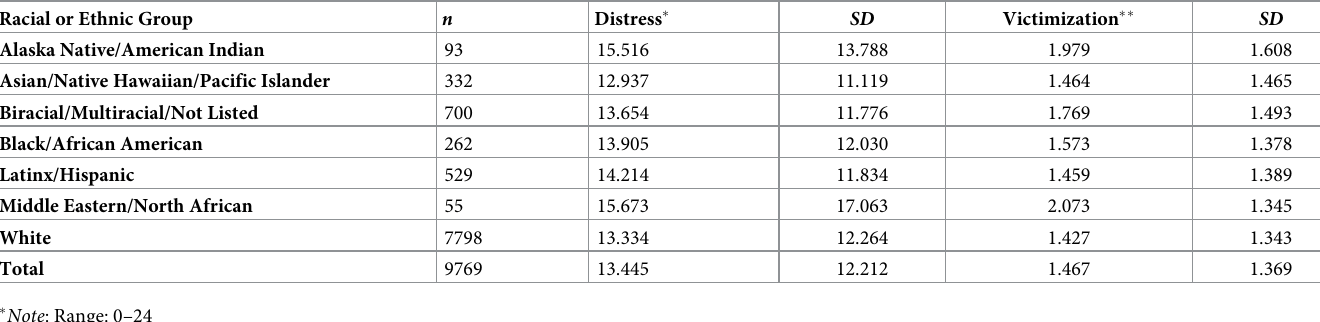
Table 2. Means for distress and victimization by racial/ethnic group.